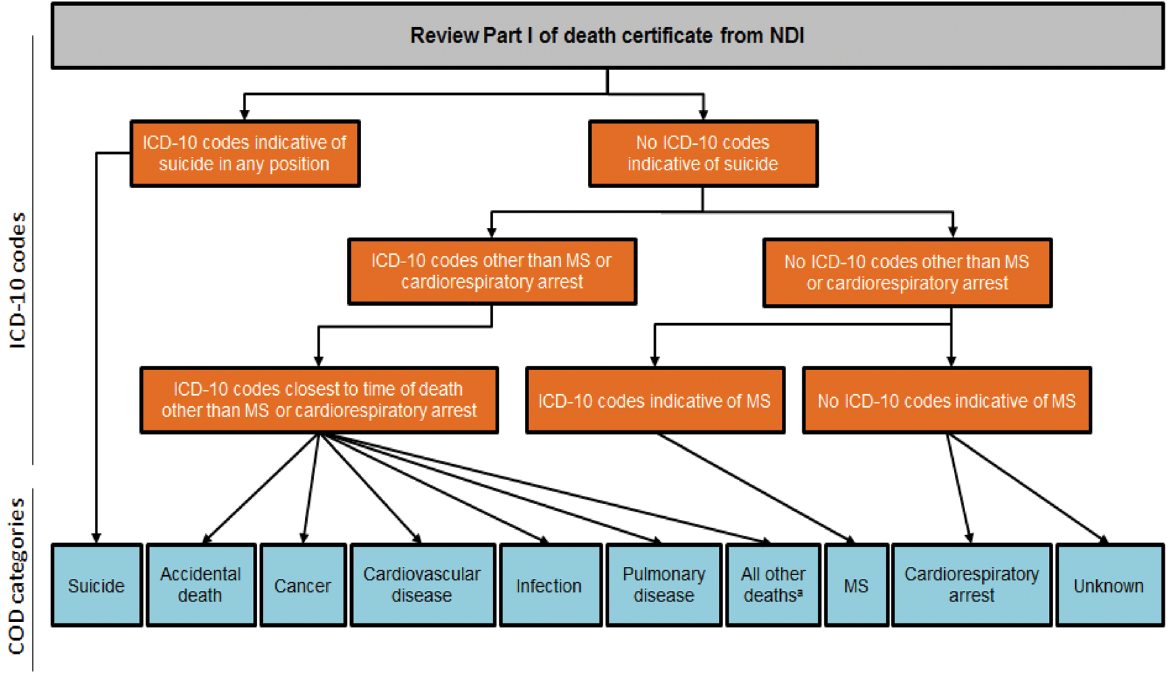
Figure 2. Algorithm for determining principal cause of death (COD) and primary disease/injury categories. The algorithm used to determine the principal COD based on ICD-10 codes. These codes were then sorted into 10 major disease/injury categories. a Includes all ICD-10 codes not assigned to one of the other categories; examples include diabetes mellitus, all gastrointestinal diseases, hematologic diseases, etc.